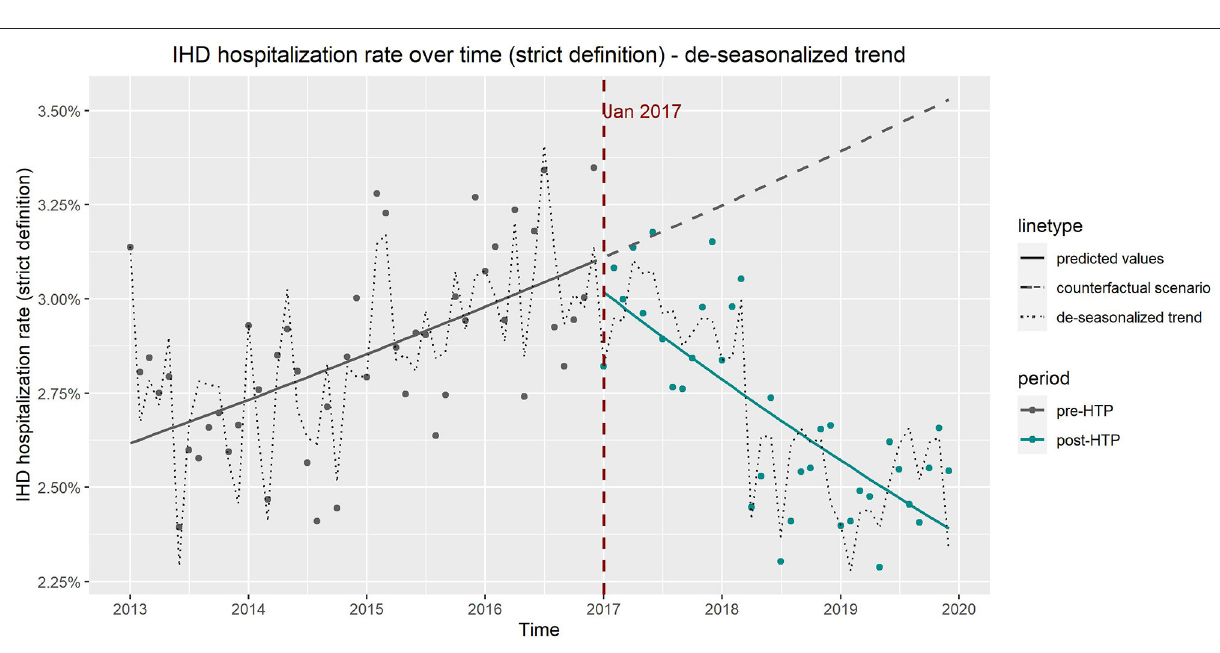
FIGURE 5 | Observed vs. expected trends in hospitalizations due to ischemic heart disease from results of interrupted time series model which includes age, sex, and seasonality as covariates and de-seasonalized time trend, using only Diagnosis Procedure Combination